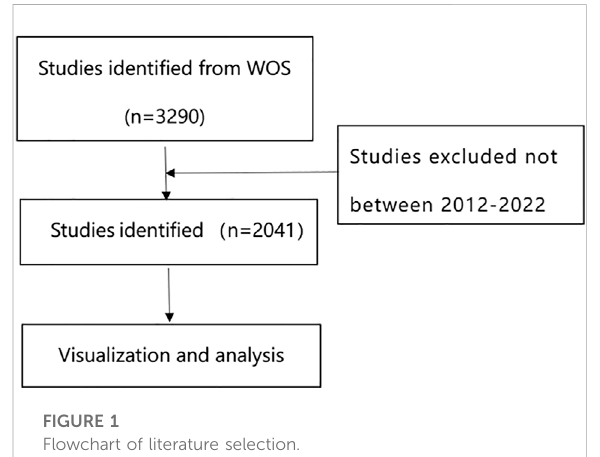
FIGURE 1 Flowchart of literature